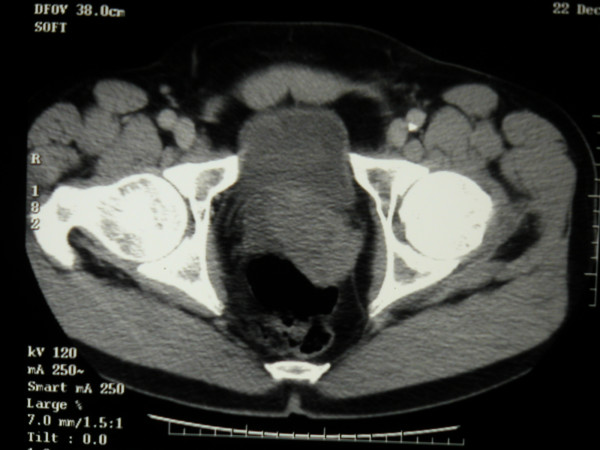
CT scan showing a prostatic deposit of tumour metastases prior to chemotherapy.